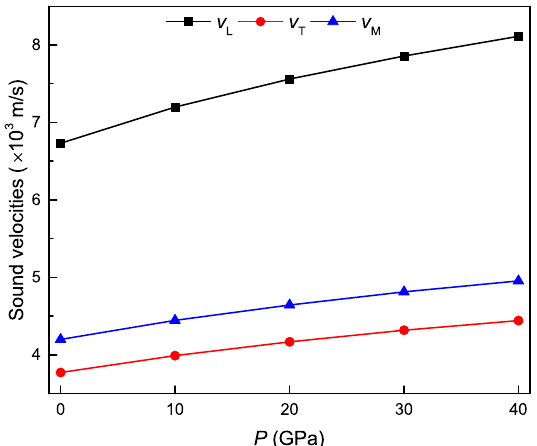
Figure 11. Polycrystal longitudinal, transverse and average sound velocities as a function of pressure for the Ti 4 Nb 3 Al 9